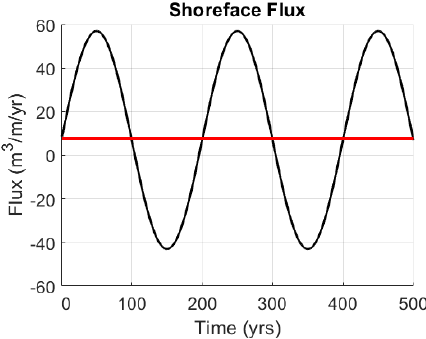
Figure 6. Shoreface flux Q S supplied as a function of sine wave centered on + 7m 3 m − 1 yr − 1 (net